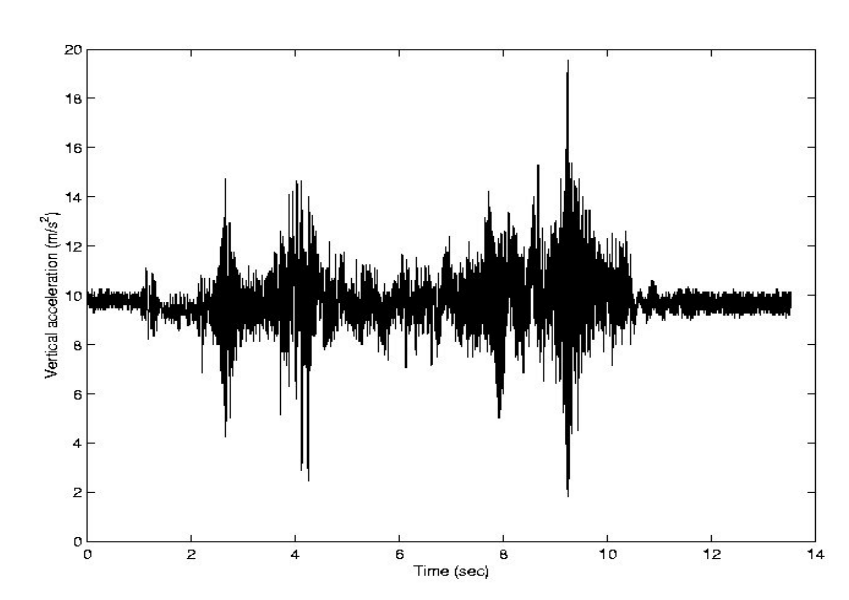
Figure 8. Vertical acceleration (m/s 2 ) vs. Time